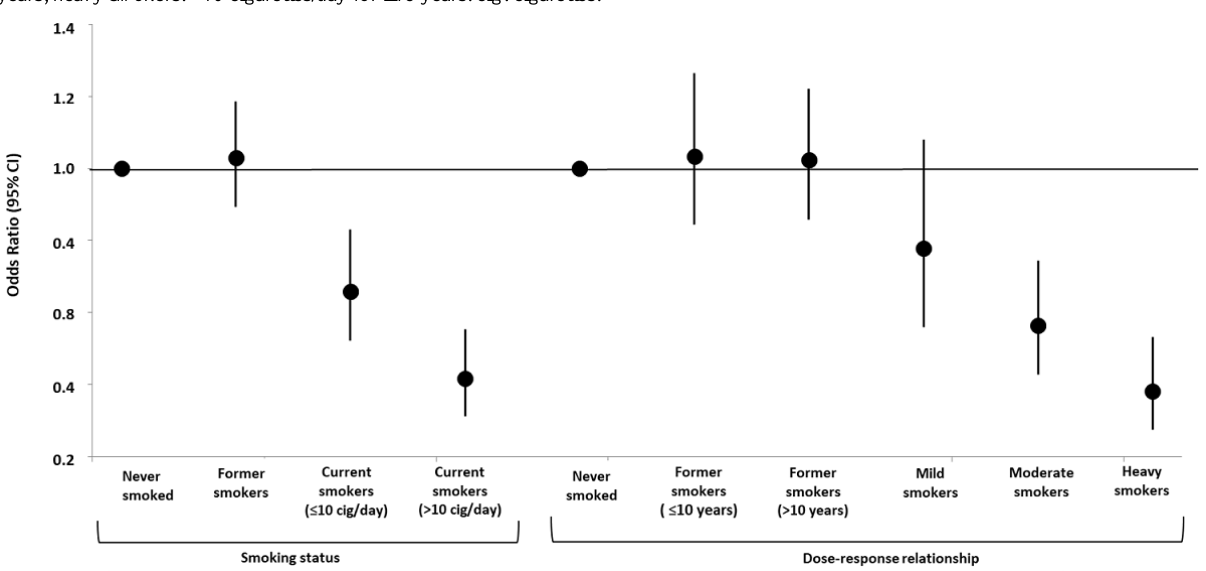
Figure 2. Adjusted odds ratios and relative 95% CIs for smoking status, intensity, and duration (N=6857). Odds ratios were adjusted for age, sex, education, occupation, area of residence, heart diseases, lung diseases, hypertension, metabolic and oncological diseases, contact with confirmed or suspected COVID-19 cases, living area, crowding index, and living with at-risk cohabitants. Dots and vertical lines indicate adjusted odds ratios and 95% CIs, respectively. Mild smokers: ≤ 10 cigarettes/day for <15 years; moderate smokers: ≤ 10 cigarettes/day for ≥ 15 years or >10 cigarettes/day for <15 years; heavy smokers: >10 cigarettes/day for ≥ 15 years. cig: